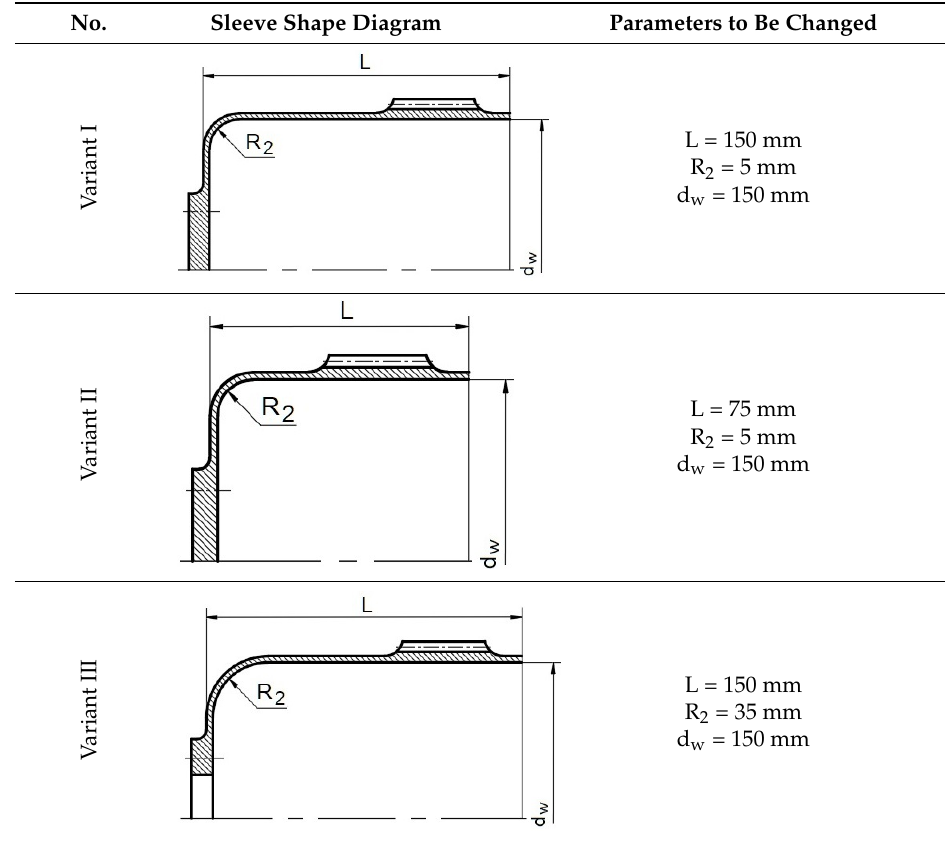
Table 1. Shapes of flexsplines used in the next part of the calculation.